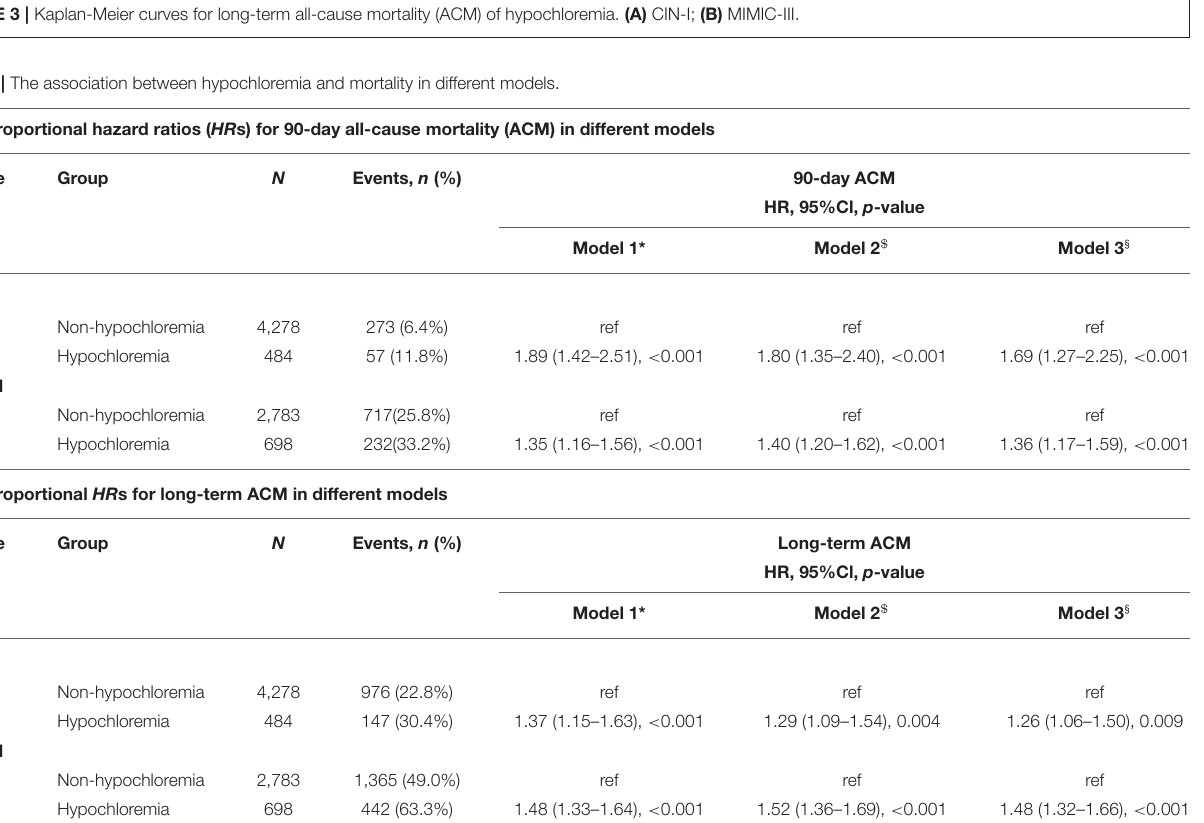
FIGURE 3 | Kaplan-Meier curves for long-term all-cause mortality (ACM) of hypochloremia. (A) CIN-I; (B) MIMIC-III.